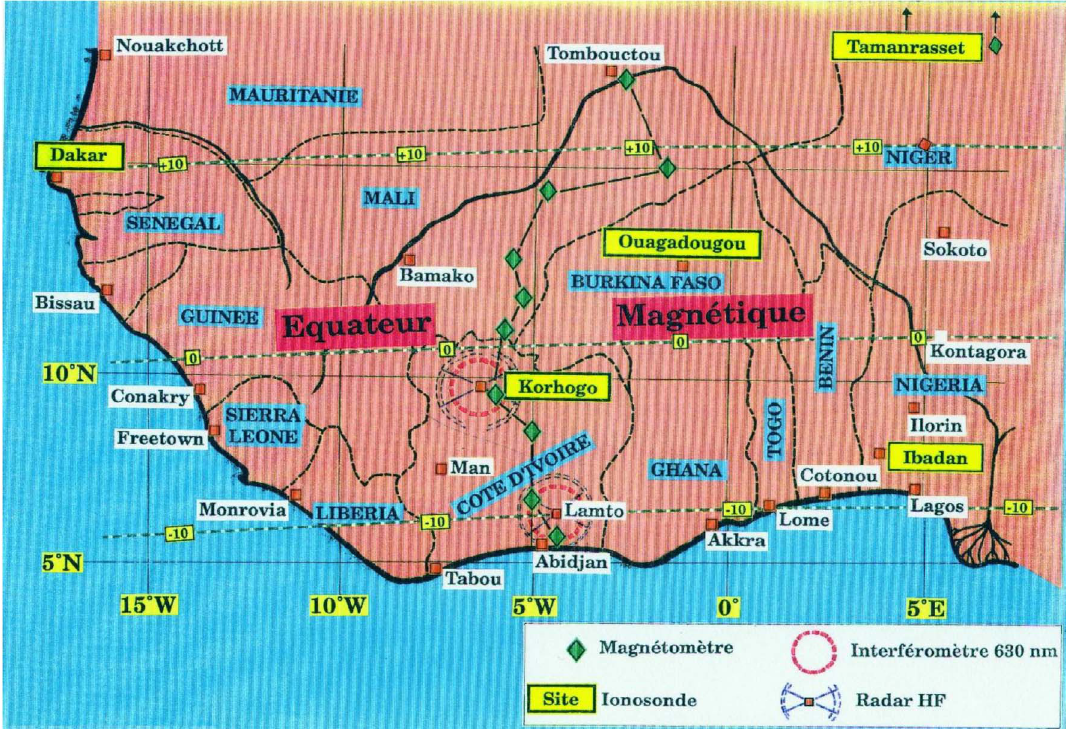
Fig. 1. Scienti fi c tools in West Africa during the IEEY project: in yellow the fi ve ionosondes and in green the chain of ten magnetotelluric stations. Two observatories of Korhogo and Lamto are represented by red